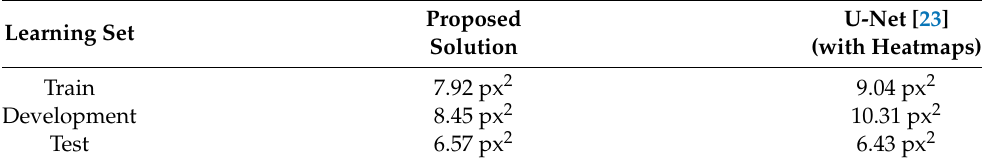
Table 2. CNN loss function (7) values for different learning sets. Learning